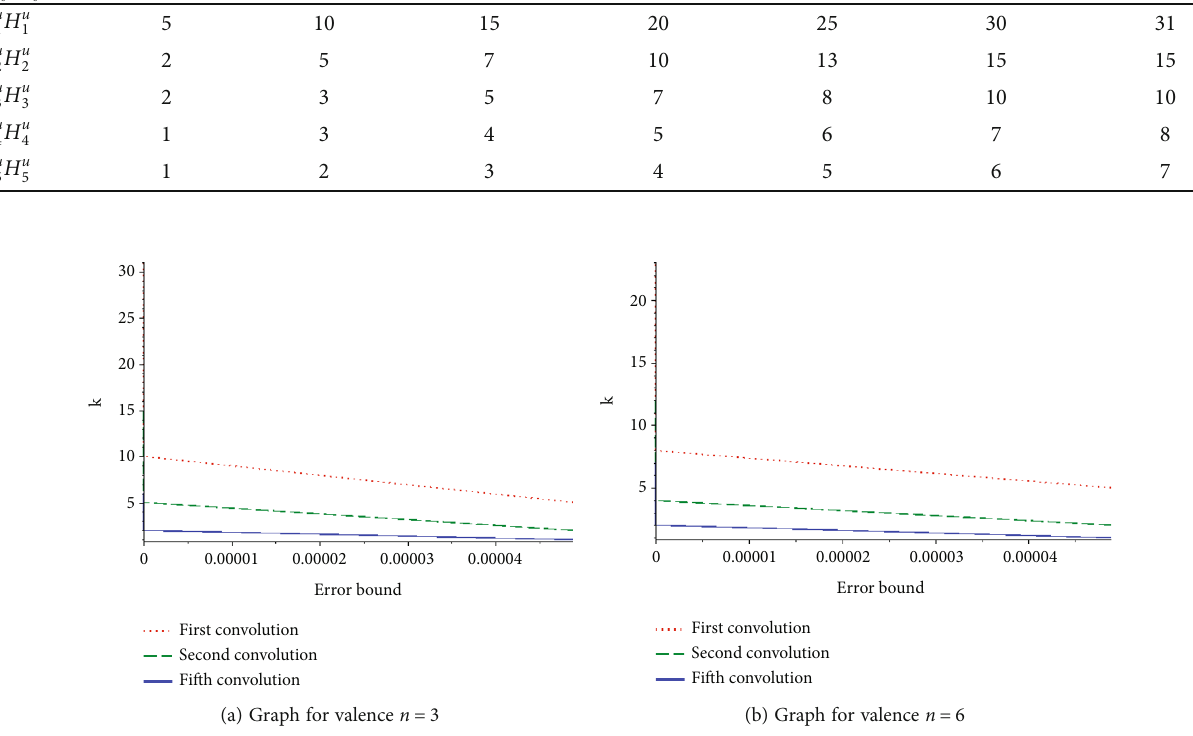
Figure 3: Presentation of subdivision depth by taking fi rst, second, and fi fth level of